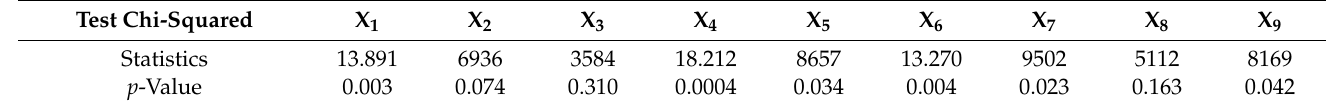
Table 8. “Smart and efficient energy systems” aspect—Kruskal–Wallis test